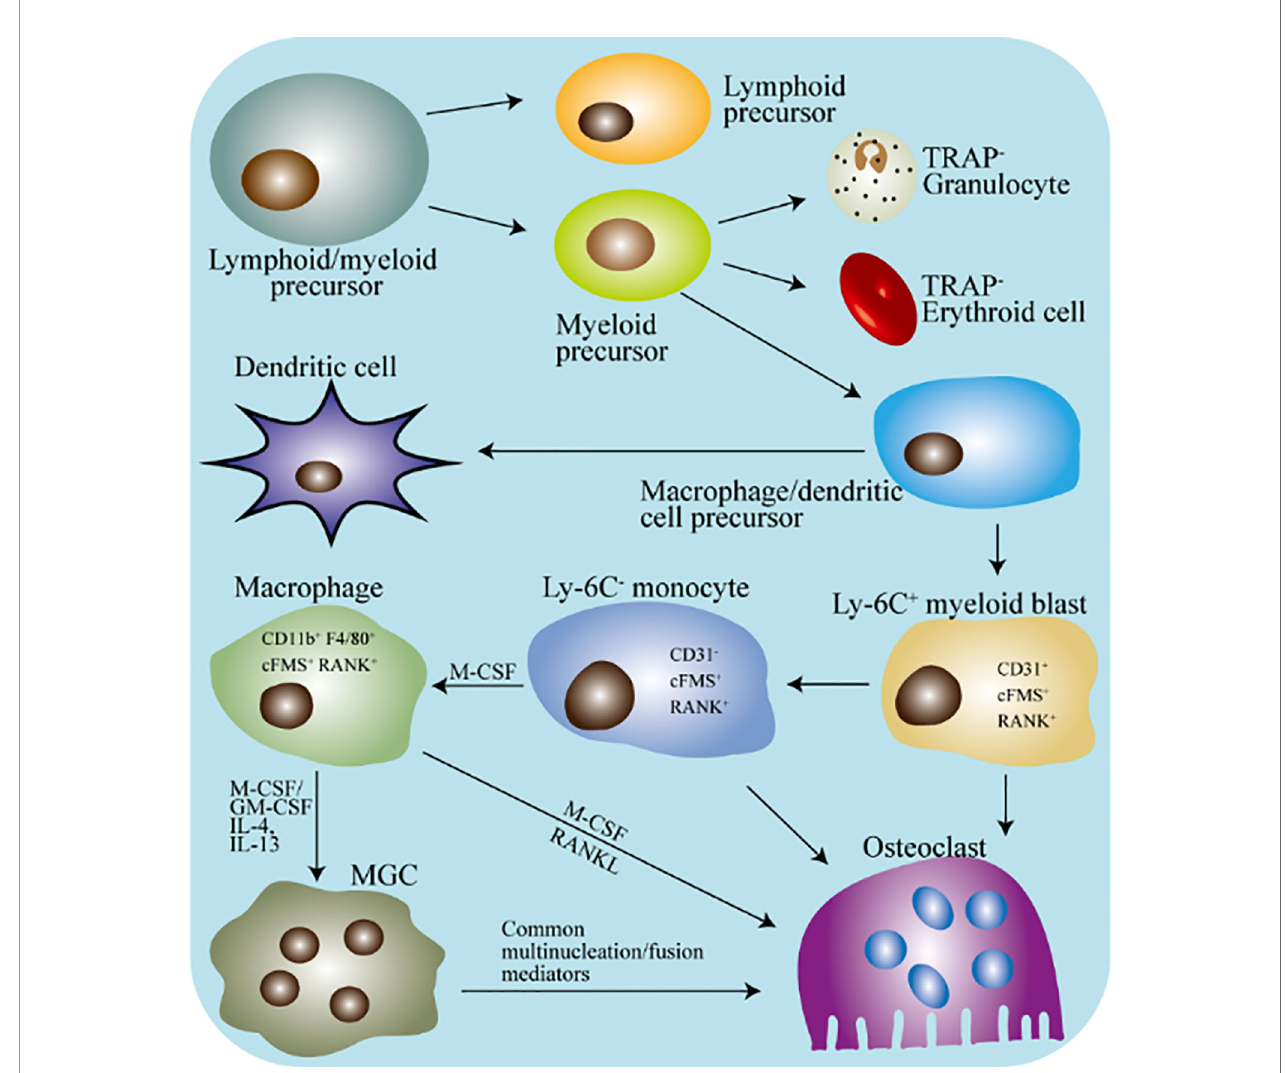
FIGURE 2 | Schematic diagram of the differentiation of macrophages and osteoclasts in mice. TRAP, tartrate-resistant acid phosphatase; MGC, multinucleated giant cell; M-CSF, macrophages colony-stimulating factor; GM-CSF, granulocyte macrophages colony stimulating factor. The hematopoietic stem cells differentiate into lymphoid/myeloid precursors, and the myeloid precursors further produce dendritic cells/macrophages precursors. Under appropriate stimulation, macrophages precursors will continue to differentiate into speci fi c marked monocytes. Next, under the stimulation of M-CSF, speci fi cally marked monocytes differentiate into tissue- speci fi c macrophages. Tissue-speci fi c macrophages can directly fuse into osteoclasts, or they can fuse into MGC fi rst and then differentiate into